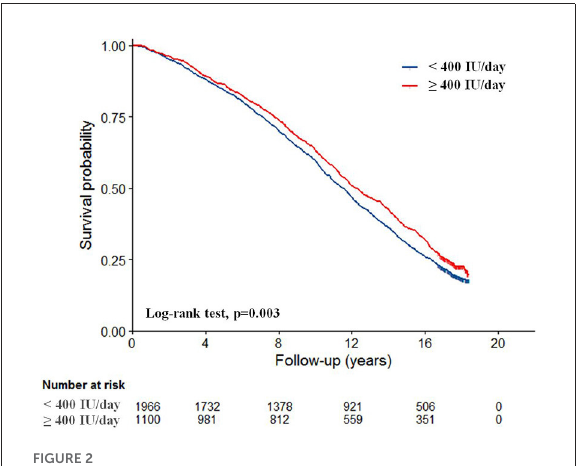
FIGURE2 Kaplan-Meier survival curves according to dietary vitamin D intake ( n = 3,066).